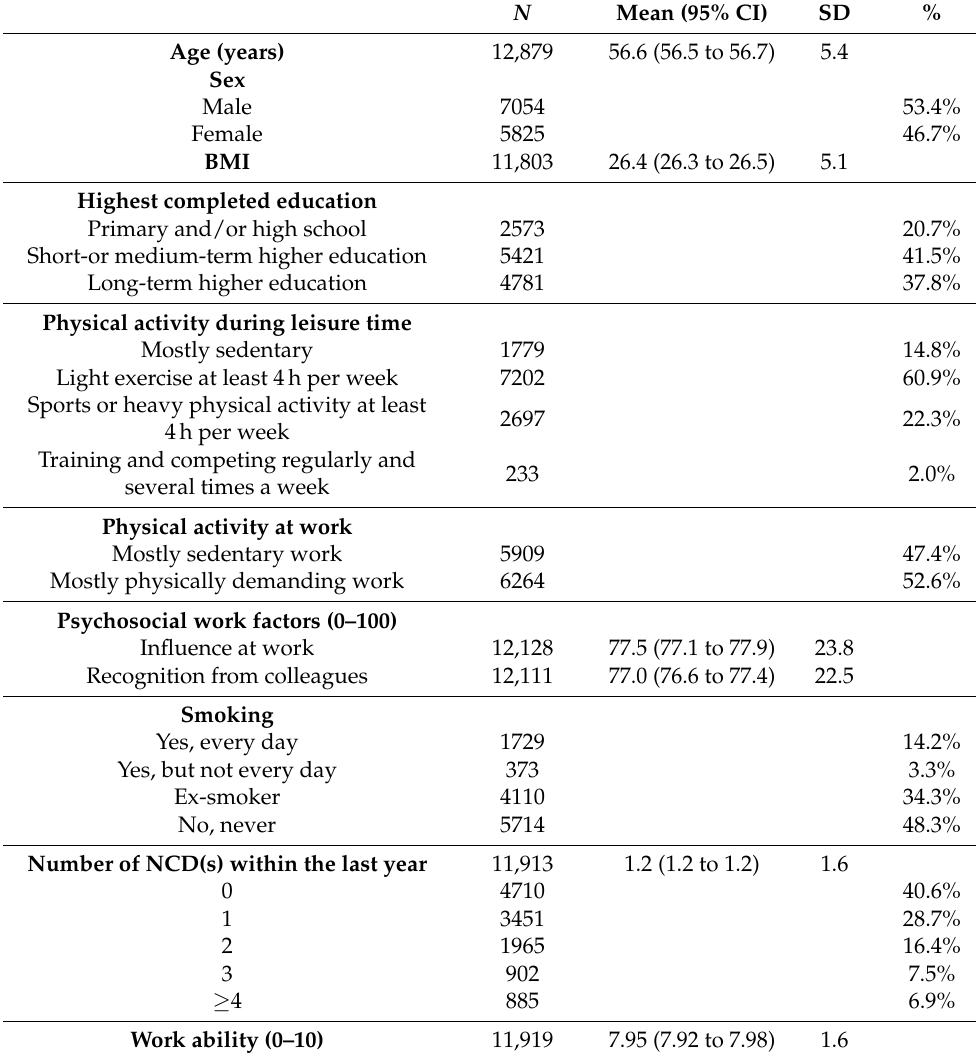
Table 1. Demographic, lifestyle, diseases, and work-related characteristics of the included participants. Weighted means and percentages.